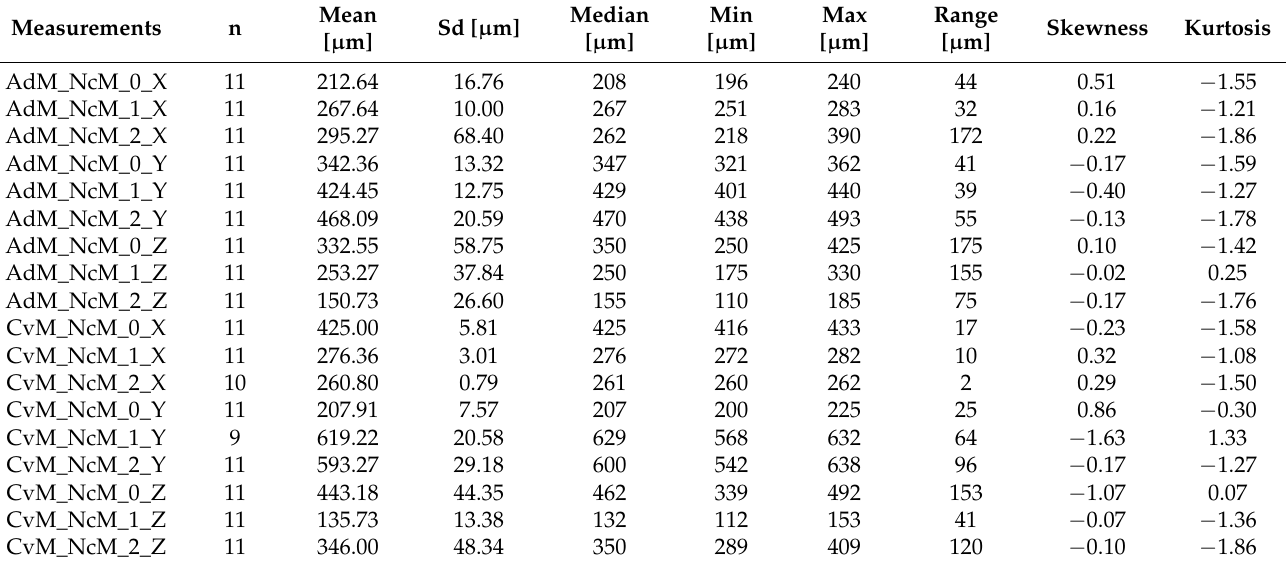
Table 8. Descriptive statistics NcM for Arm I—AdM and Arm I—CvM.